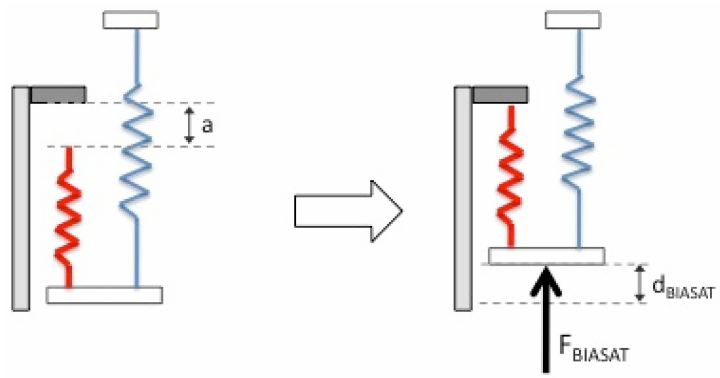
Figure 7. Schematic of the BIASAT mechanism.